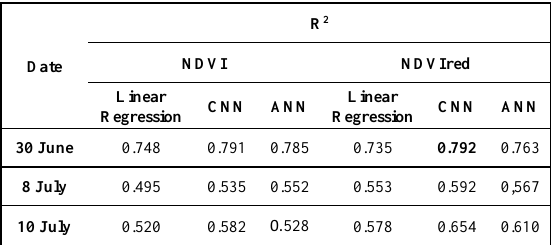
Table 3. R 2 results obtained from the methods and